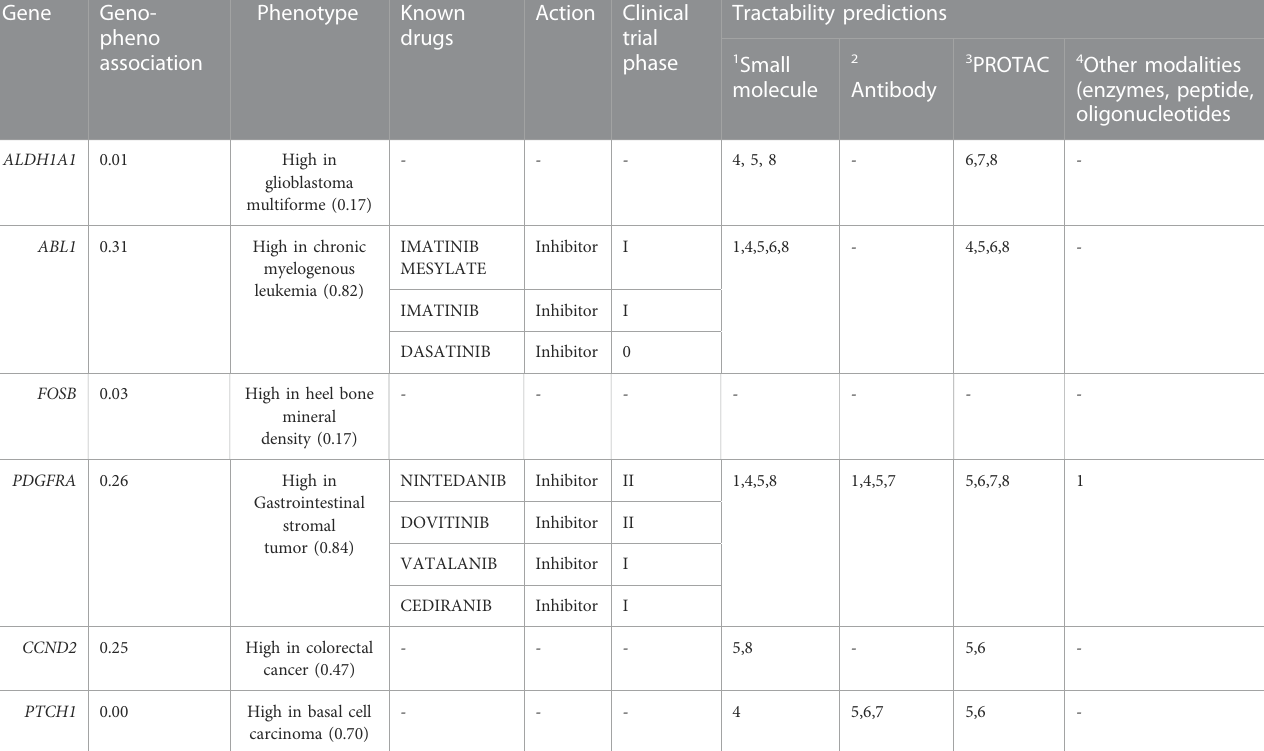
TABLE 4 Open target platform phenotype association and Target trackability assessment of the endometrial cancer hub genes. Gene